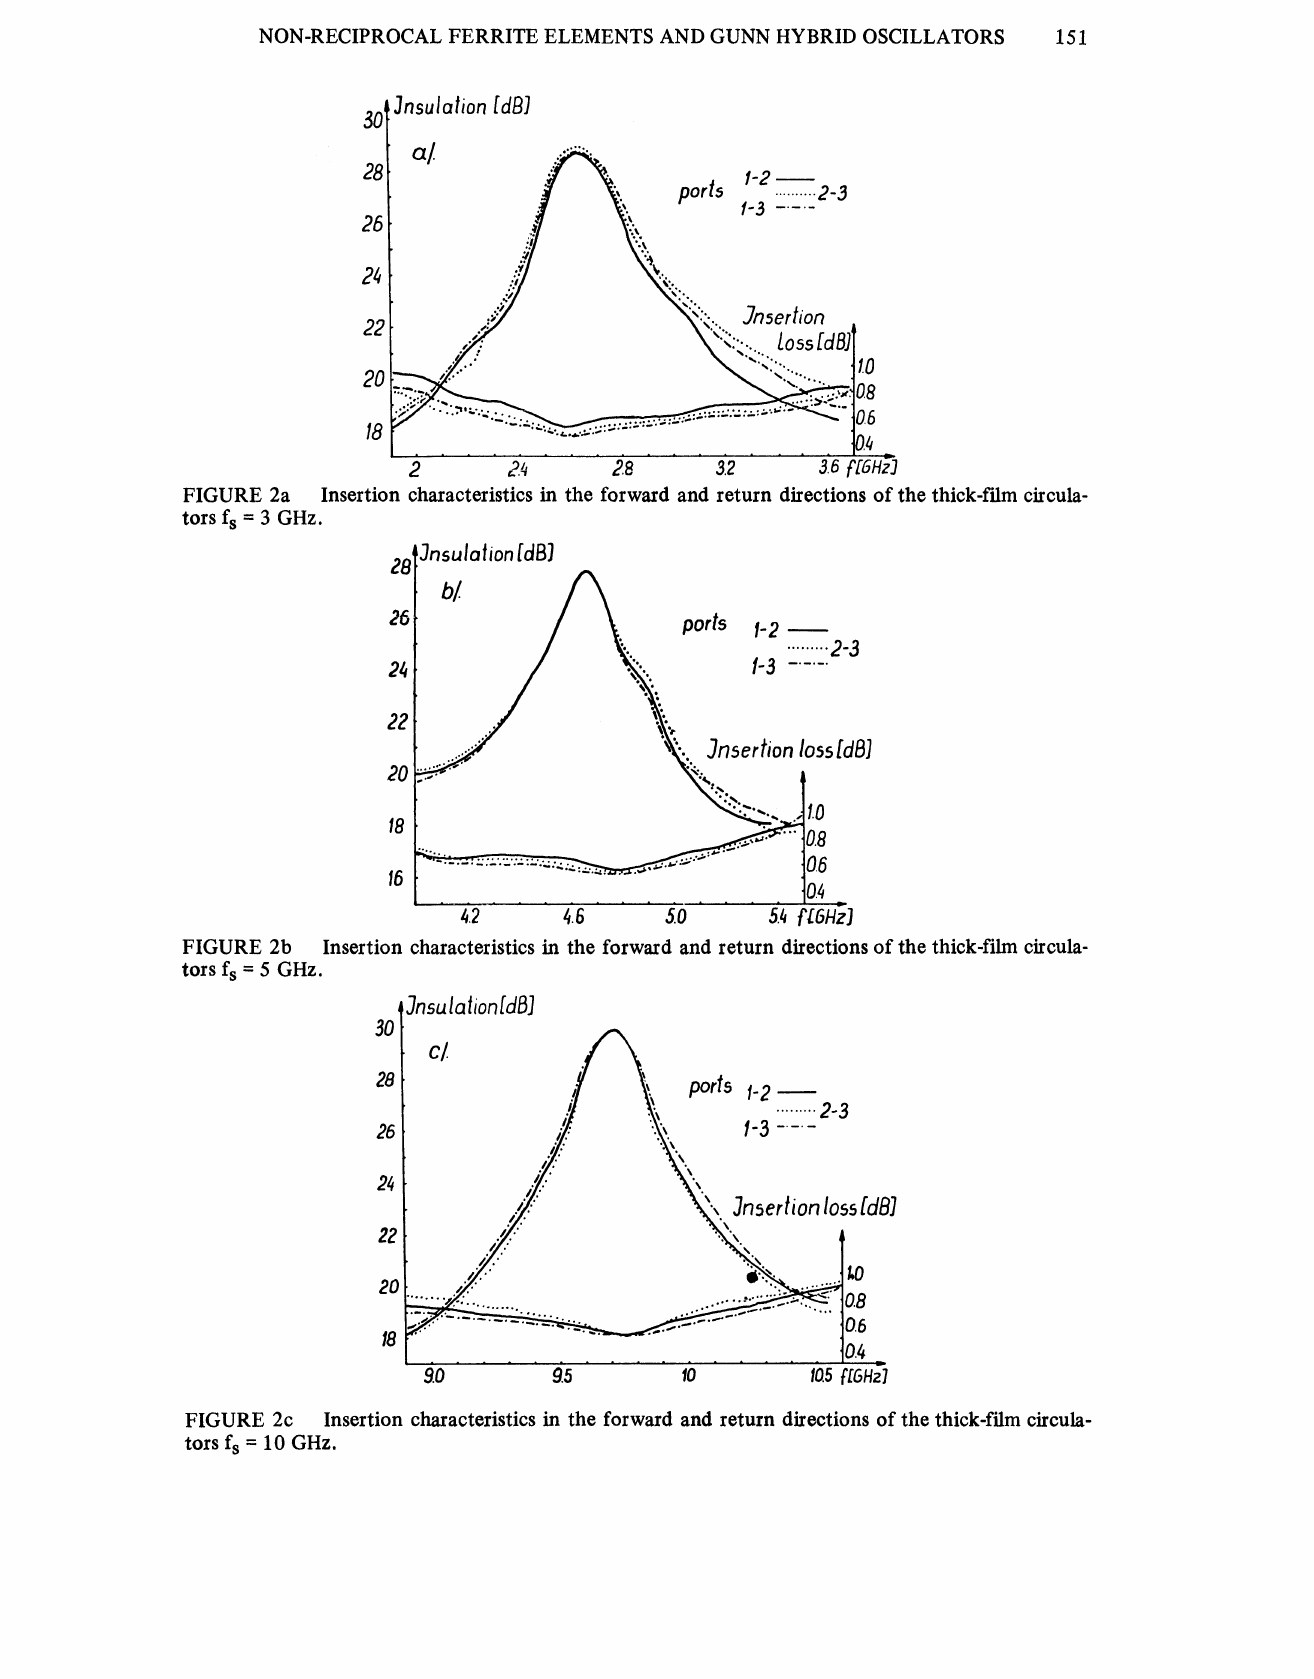
FIGURE 2a tots fs 3 GHz.